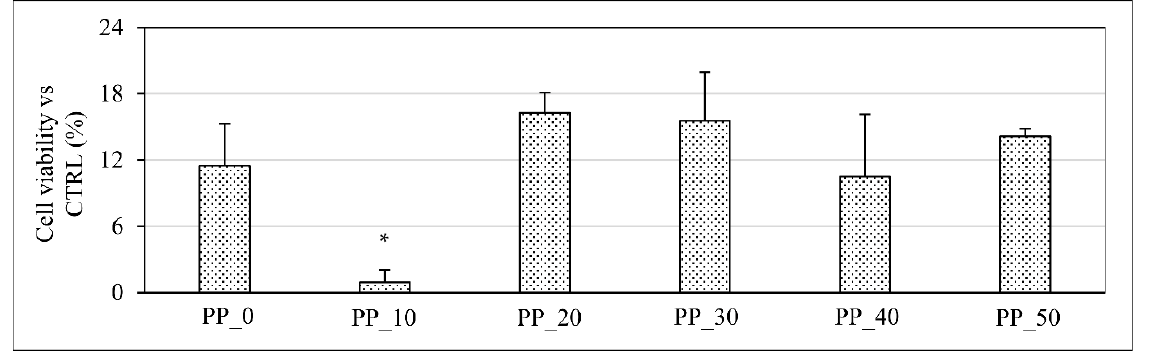
between themselves ( p < 0.05). * Data marked with the same symbol are statistically different ( p < 0.05).